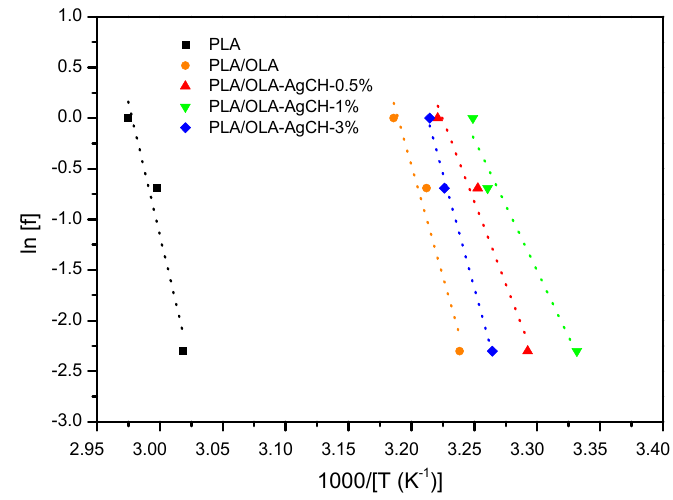
Figure 3. Plot of (1/T g ) vs. ln f based on tan δ peaks for the different systems.